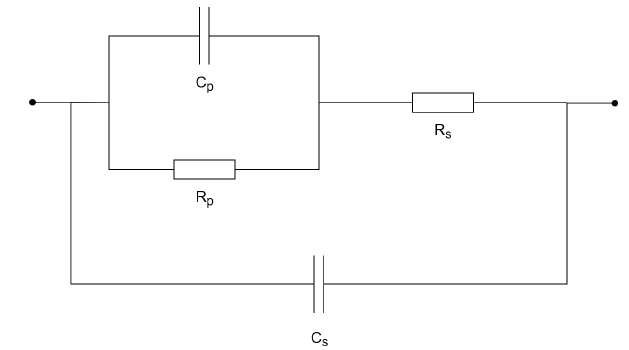
Figure 4. Electrical equivalent circuit of the measurement set-up for capacitance